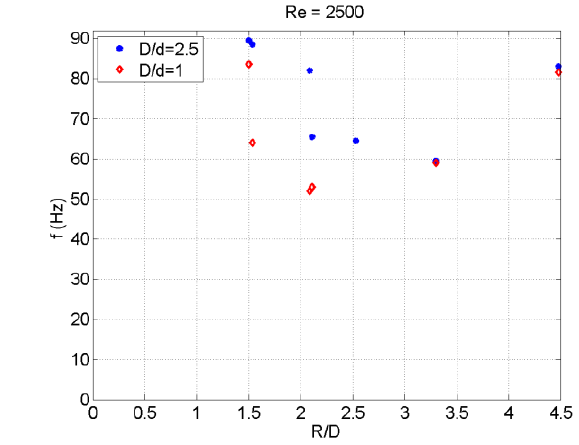
Figure 7. Relationship between the frequency and the pitch distance for Re 1200